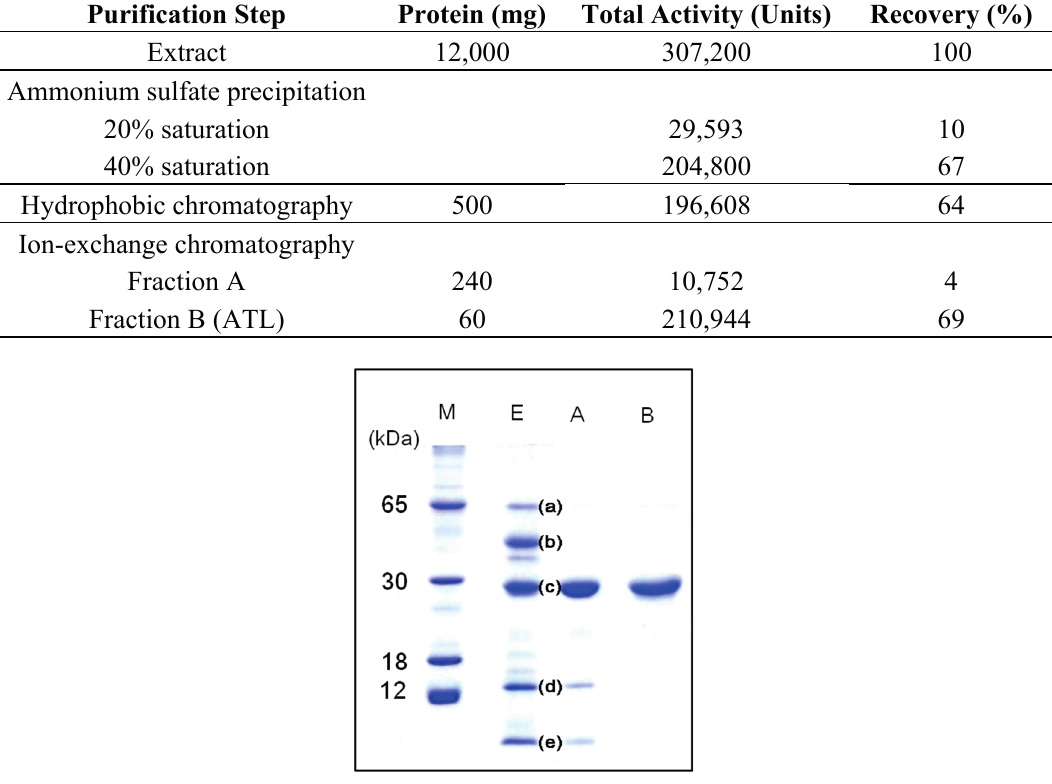
Figure 2. SDS-PAGE patterns of Apios tuber proteins in 15% acrylamide gel under reducing condition. Lanes M: Protein markers, E: Apios protein fraction obtained by ammonium sulfate precipitation, A: Fraction A; B: Fraction B ( Apios tuber lectin).